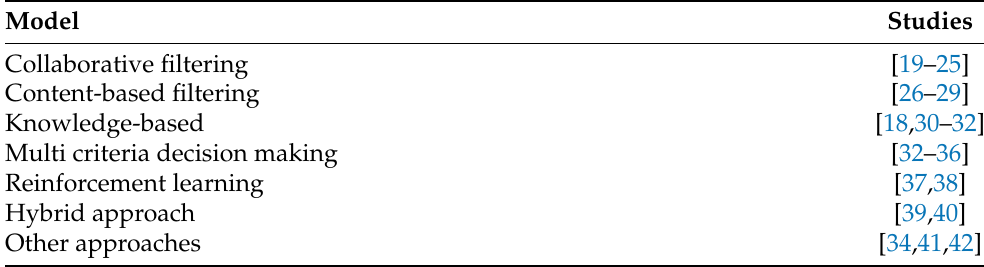
Table 2. Categorization of papers based on their methodological